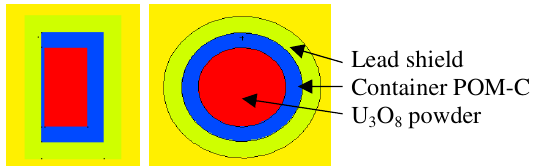
Fig. 13. Lead shield simulation around HEU source.